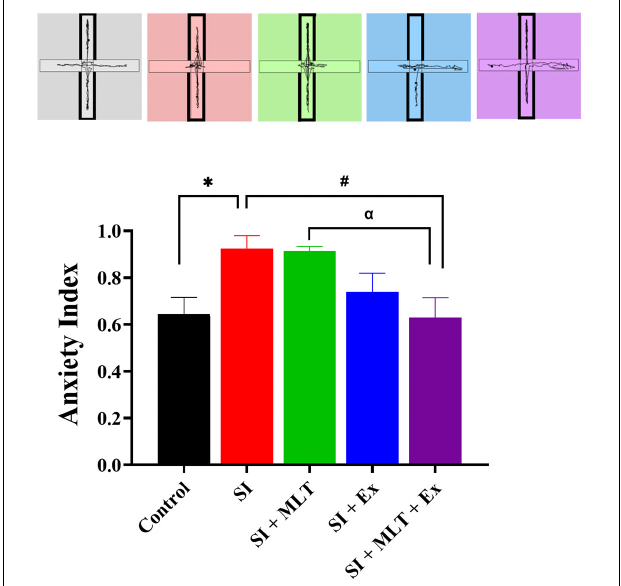
FIGURE 5 | The effect of MLT and Ex on the anxiety index among groups in the EPM. Data are presented as mean ± SEM. One-way ANOVA was used, followed by Tukey’s multiple comparisons test. ∗ indicates a significant difference between the treated groups and the control group at p > 0.05; # indicates a significant difference between the treated groups and the SI group at p > 0.05; α indicates a significant difference between the treated groups and the combination group at p > 0.05.